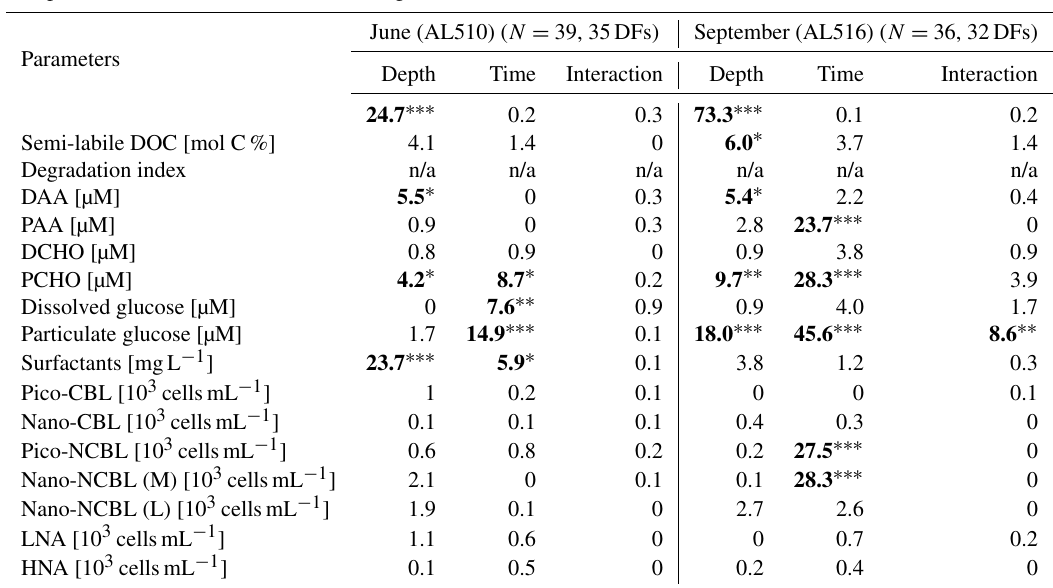
Table A5. Statistics of differences in concentrations between the sea surface microlayer and the underlying water and between morning and afternoon stations summarized for each season. This table refers to the concentrations represented for depths in Table A3 and for time in Table A4. Bold numbers indicate significance while the asterisks mark the level of significance ( ∗ p value < 0 . 05; ∗∗ p value < 0 . 01; ∗∗∗ p value < 0 .